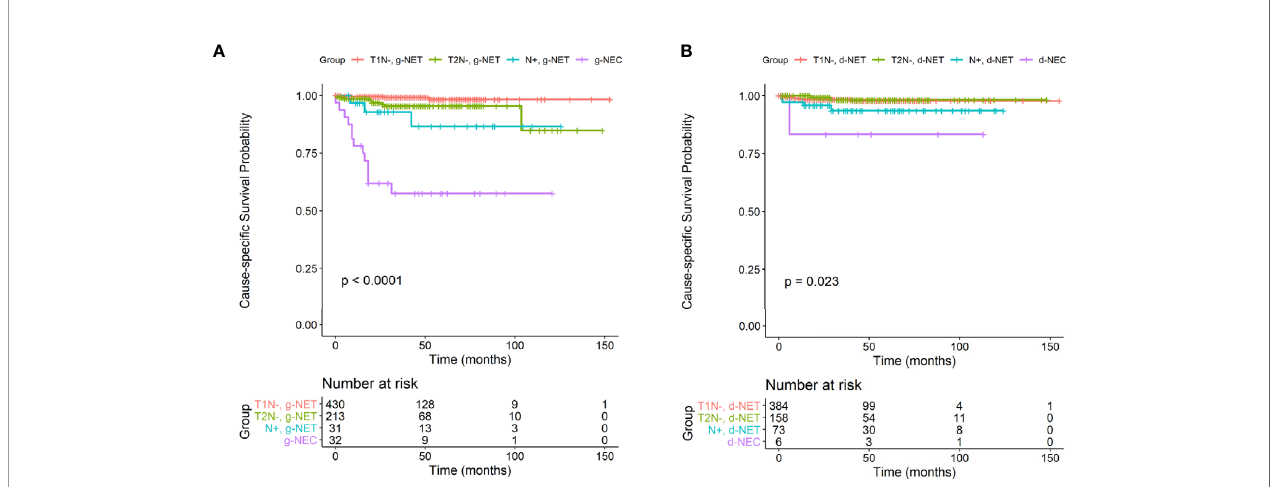
FIGURE 2 | Cause-speci fi c survival in four clinical subgroups (T1 nodal-negative NETs, T2 nodal-negative NETs, nodal-positive NETs, and NECs) among patients with g-NENs (A) and d-NENs (B) . NET, neuroendocrine tumor; NEC, neuroendocrine carcinoma; g-NEN, gastric neuroendocrine neoplasm; d-NEN, duodenal neuroendocrine